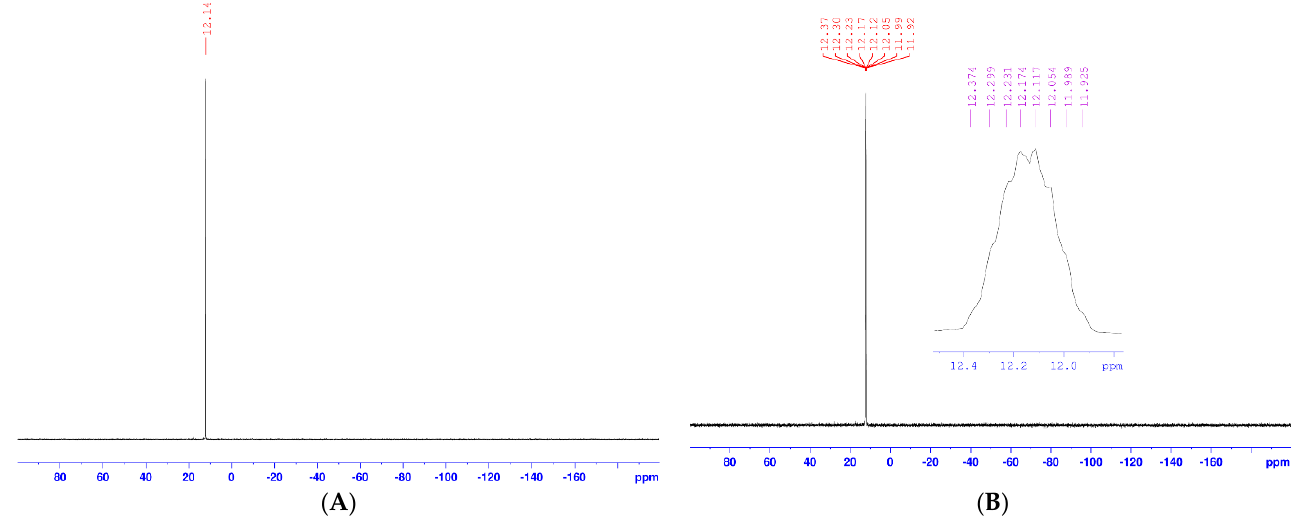
Figure 1. ( A ). Decoupled 31 P NMR spectrum of cycloadduct ( 3 ). ( B) Coupled 31 P NMR spectrum of cycloadduct ( 3 ).